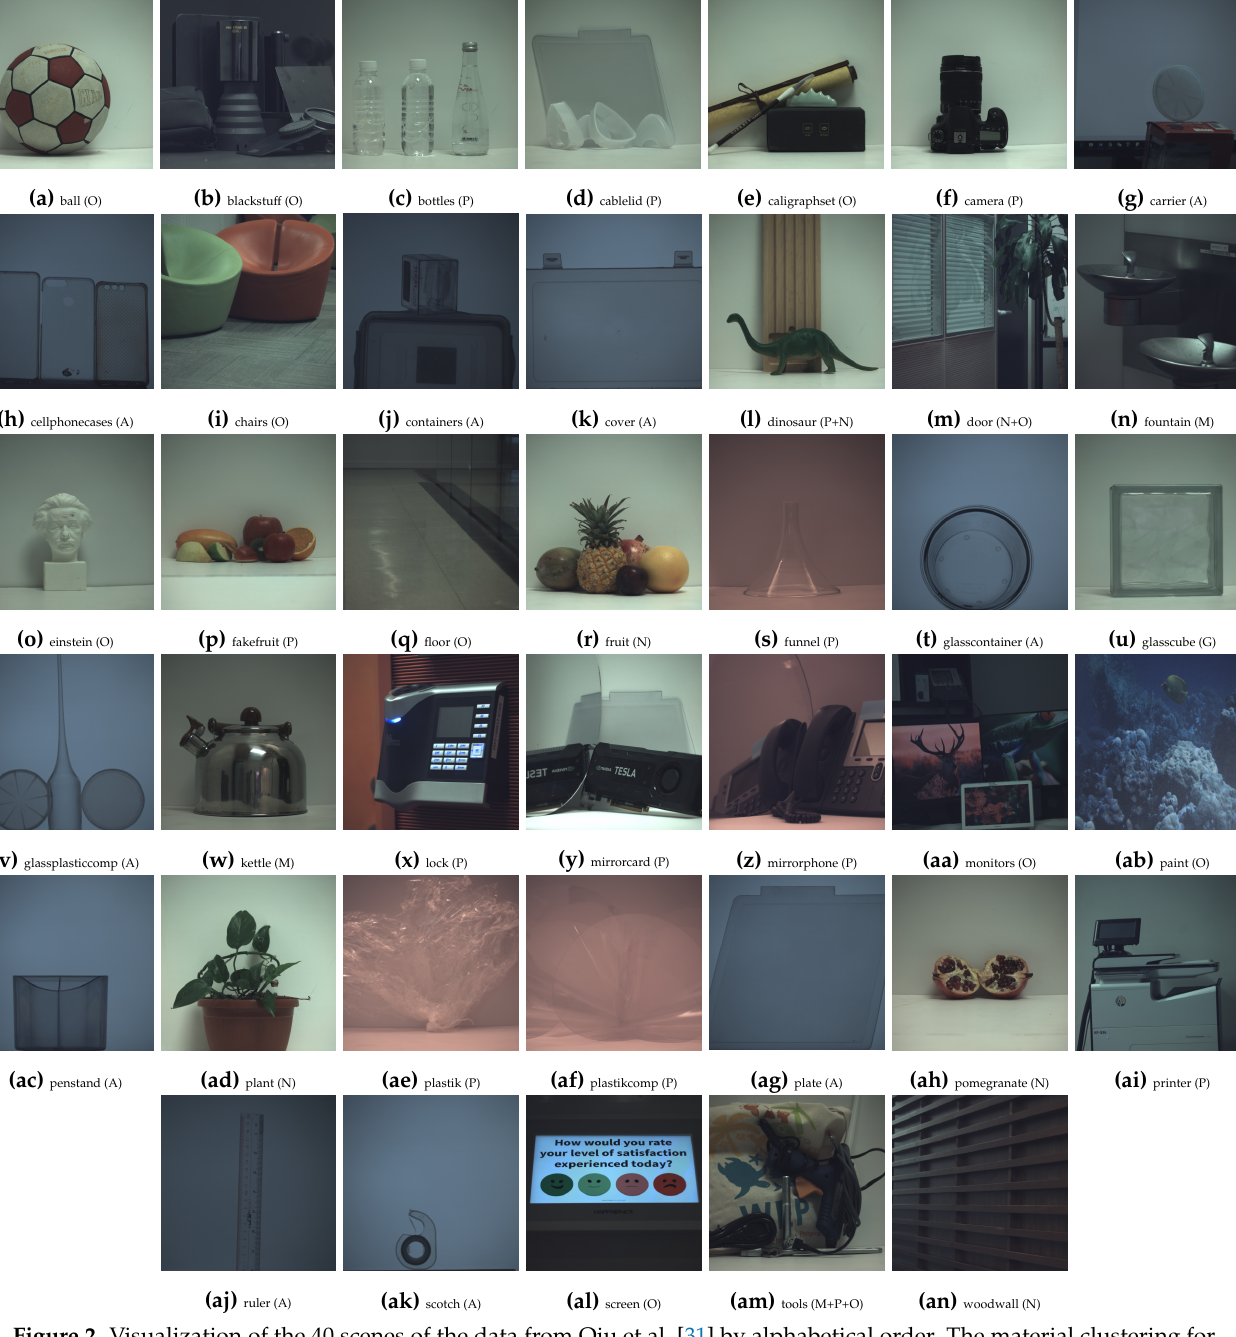
Figure 2. Visualization of the 40 scenes of the data from Qiu et al. [31] by alphabetical order. The material clustering for each scene is represented by the acronym: M (Metallic), N (Natural), A (Active), P (Plastic), G (Glass), and O